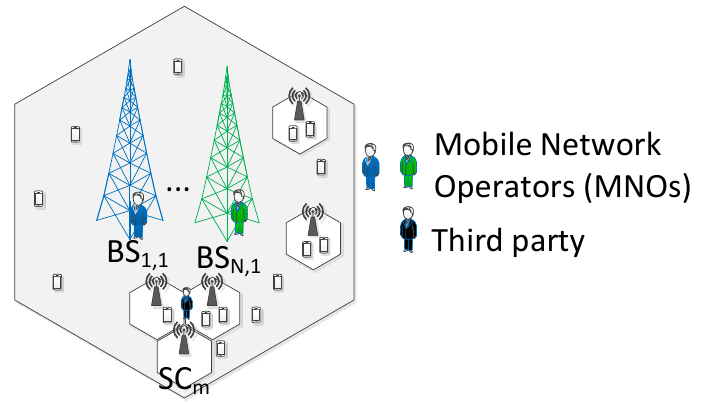
Figure 1. Network with a macro cell served by N MNOs and M